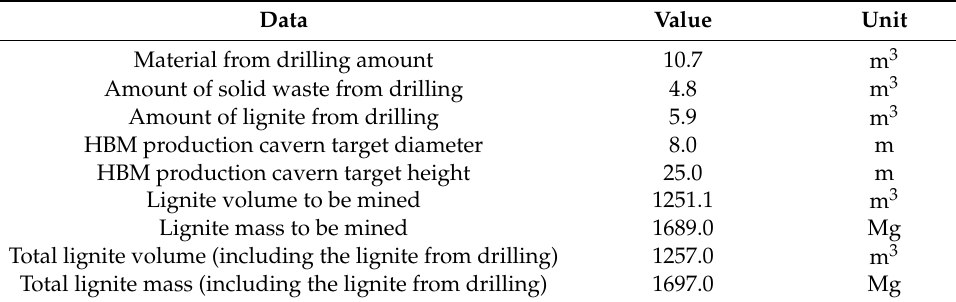
Table 3. Calculated complementary data on the defined